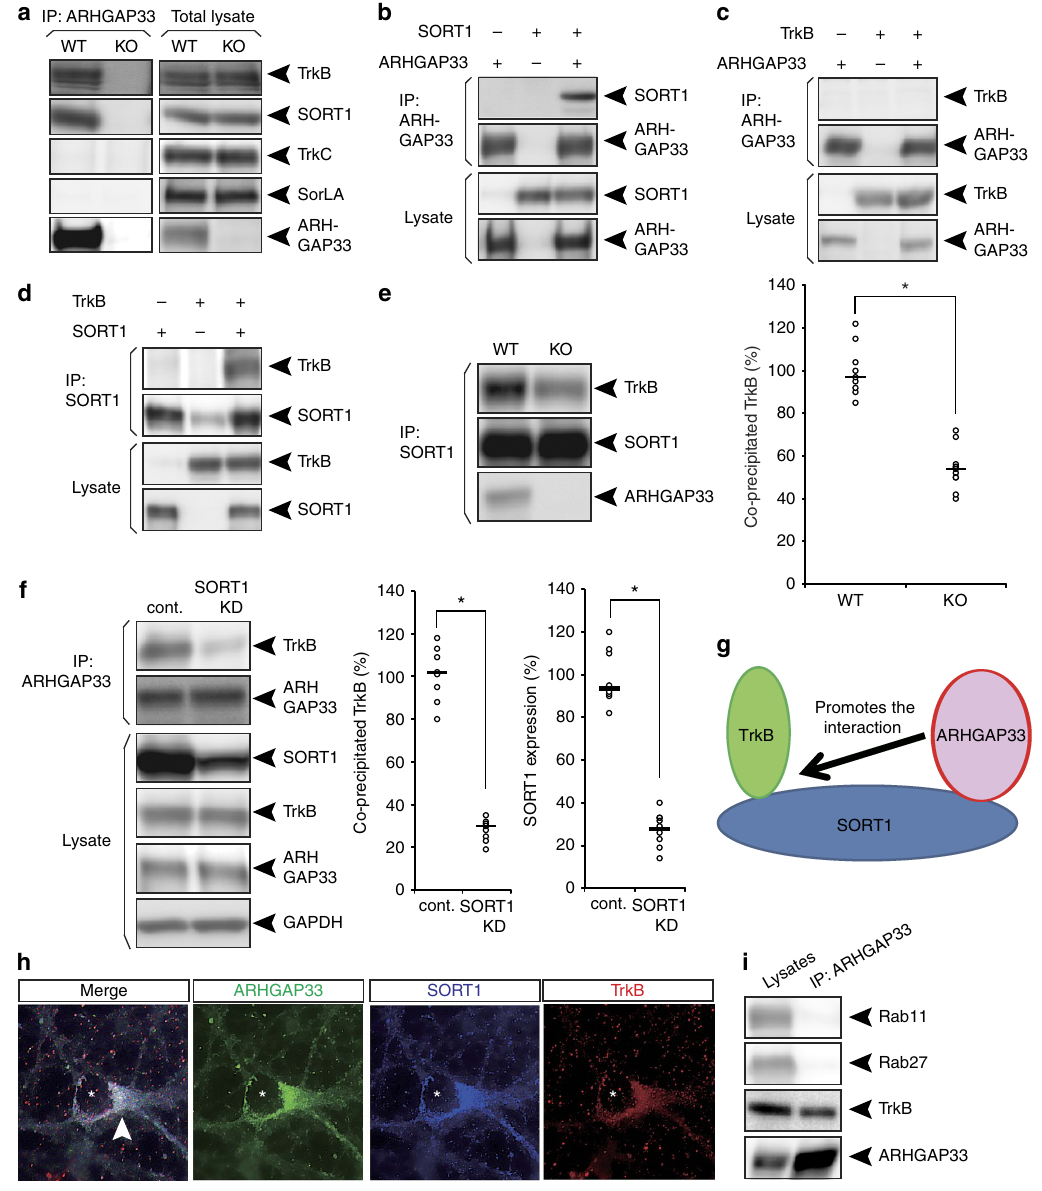
Figure 6 | ARHGAP33 promotes the interaction between TrkB and SORT1. ( a ) ARHGAP33 formed complexes with SORT1 and TrkB. ARHGAP33- immunoprecipitates (left) and hippocampal total lysates (right) were immunoblotted with the indicated antibodies. ( b – d ) ARHGAP33 formed complexes with SORT1 and TrkB. HEK293Tcells were transfected with ARHGAP33, SORT1 and TrkB, as indicated. Immunoprecipitates were immunoblotted with the indicated antibodies. ( e ) Weakened interaction between TrkB and SORT1 in ARHGAP33 KO mice. SORT1 immunoprecipitates were immunoblotted with the indicated antibodies. Representative blots (left) and quantification of co-immunoprecipitated TrkB (right; each n ¼ 9; P ¼ 3.4 (cid:2) 10 (cid:3) 4 , Mann–Whitney U -test). * P o 0.05. The level of co-precipitated TrkB in ARHGAP33 KO mice was normalized to that in WTmice (the averaged WTvalue was set to 100%). Bars show median values. Western blots show representative results from nine independent experiments performed using different mice. ( f ) Weakened interaction between ARHGAP33 and TrkB in the SORT1 knockdown neuron. ARHGAP33-immunoprecipitates and total lysates were immunoblotted with the indicated antibodies. Representative blots (left), quantification of co-immunoprecipitated TrkB (centre) and quantification of SORT1 expression (confirmation of SORT1 knockdown; right; each n ¼ 8; TrkB, P ¼ 7.5 (cid:2) 10 (cid:3) 4 , SORT1, P ¼ 7.7 (cid:2) 10 (cid:3) 4 , Mann–Whitney U -test). The averaged values of the control neurons were set to 100%. * P o 0.05. Bars show median values. Western blots show representative results from eight independent experiments performed using neurons from different mice; cont., control; KD, knockdown. Note that the MISSION shRNA construct (TRCN0000034496) was used. ( g ) In the ARHGAP33/SORT1/TrkB complex, ARHGAP33 promoted the interaction between TrkB and SORT1. In addition, ARHGAP33 is suggested to recruit Cdc42 into the complex 7 . ( h ) Colocalization of ARHGAP33, SORT1 and TrkB at the perinuclear region. Triple immunostaining for ARHGAP33, SORT1 and TrkB in dissociated hippocampal neurons. Scale bar, 5 m m. The asterisks indicate the nucleus of the neuron. The arrowhead indicates the colocalization of these three proteins at the perinuclear region. The data are representative of five independent experiments. ( i ) Interactions between ARHGAP33 and Rab11 or Rab27 were not detected in the hippocampal lysates. ARHGAP33-immunoprecipitates (right) and hippocampal total lysates (left) were immunoblotted with the indicated